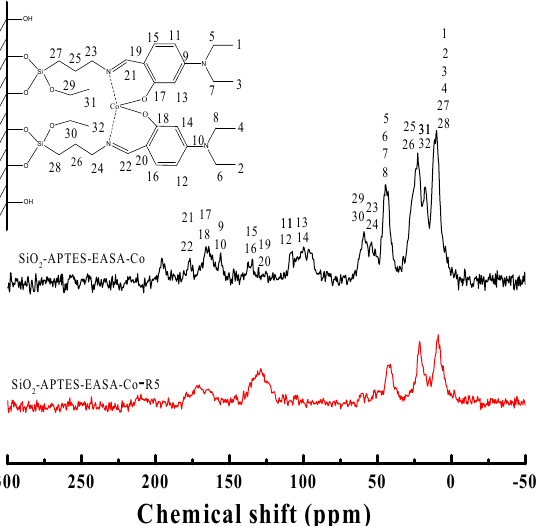
Figure 4. The 13 C NMR spectra of the fresh catalyst SiO 2 ‐ APTES ‐ EASA ‐ Co and the catalyst SiO 2 ‐ APTES ‐ EASA ‐ Co retrieved from the 6th catalytic test.